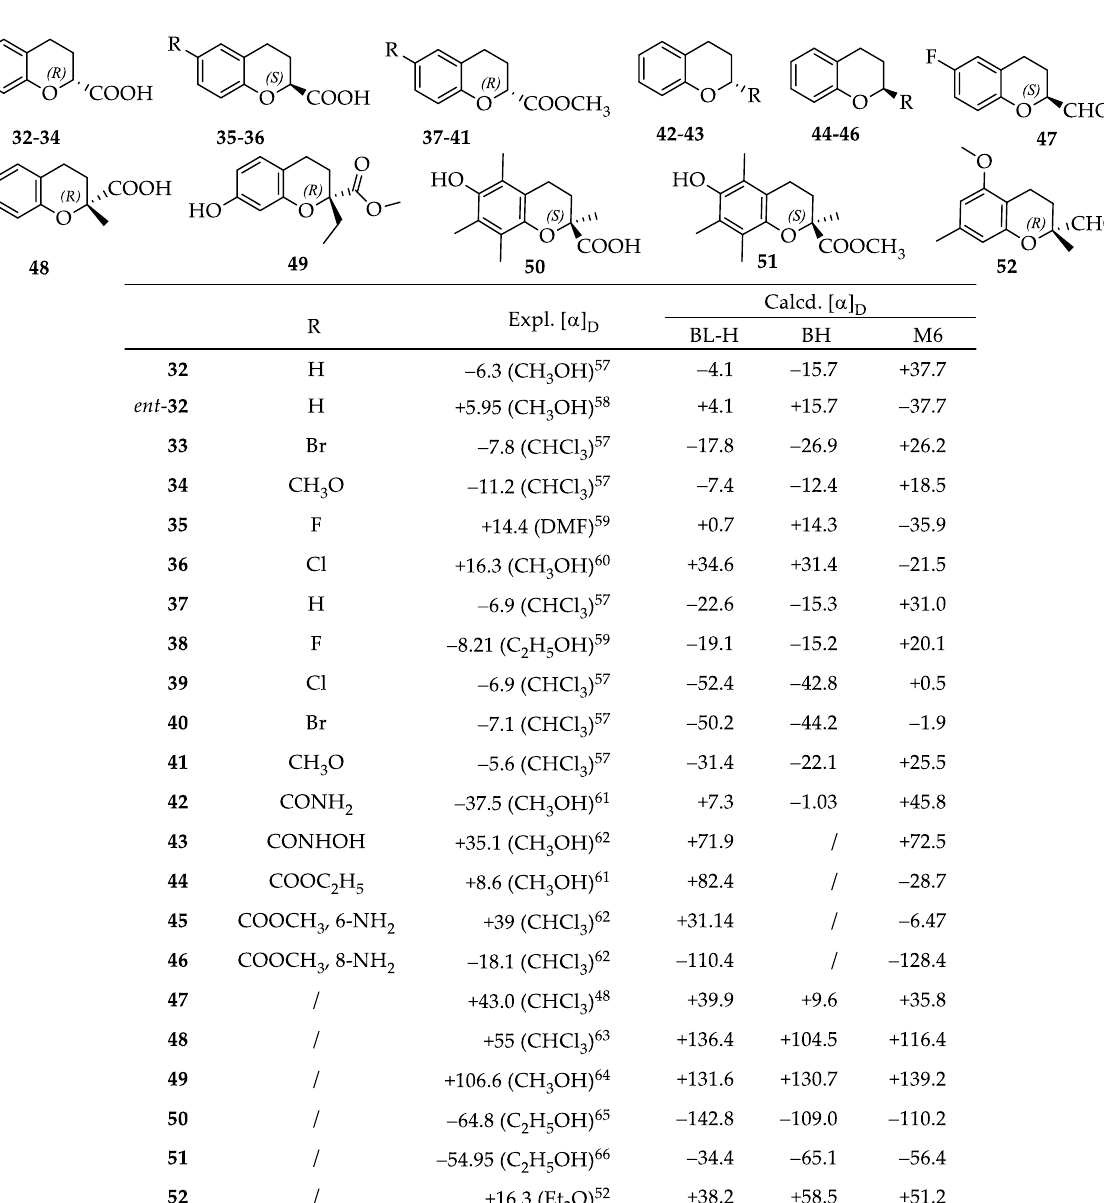
Figure 5. Experimental and predicted [α]D values for compounds 32 – 52 . BL-H: SMD/B3LYP/Aug- cc-pVDZ//B3LYP/6-311+G(d,p), BH: SMD/M06-2X/Aug-cc-pVDZ//BH&HLYP/6-311+G(d,p), M6: SMD/M06-2X/Aug-cc-pVDZ//M06-2X/TZVP. Experimental SOR data were collected